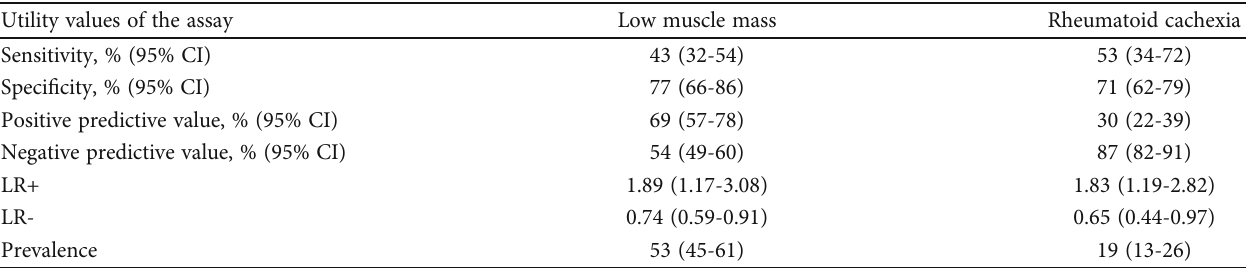
Table 4: Utility values of myostatin levels ≥ 17 ng/mL, for a biomarker of low muscle mass and rheumatoid cachexia. Utility values of the assay